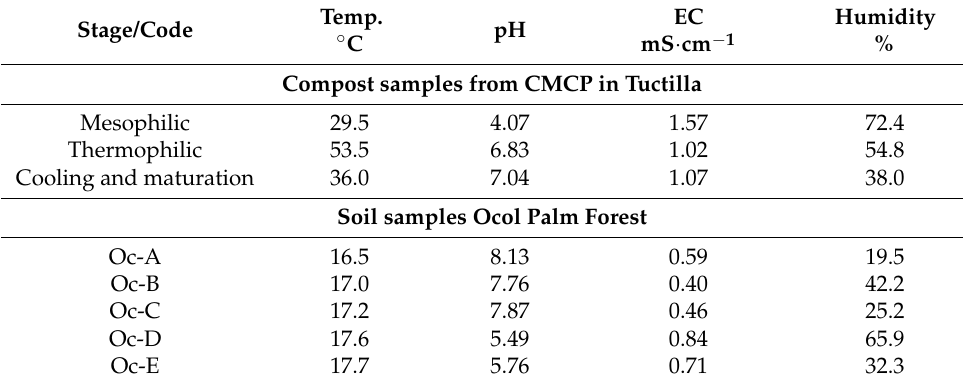
Table 1. Physicochemical characterization of the collected